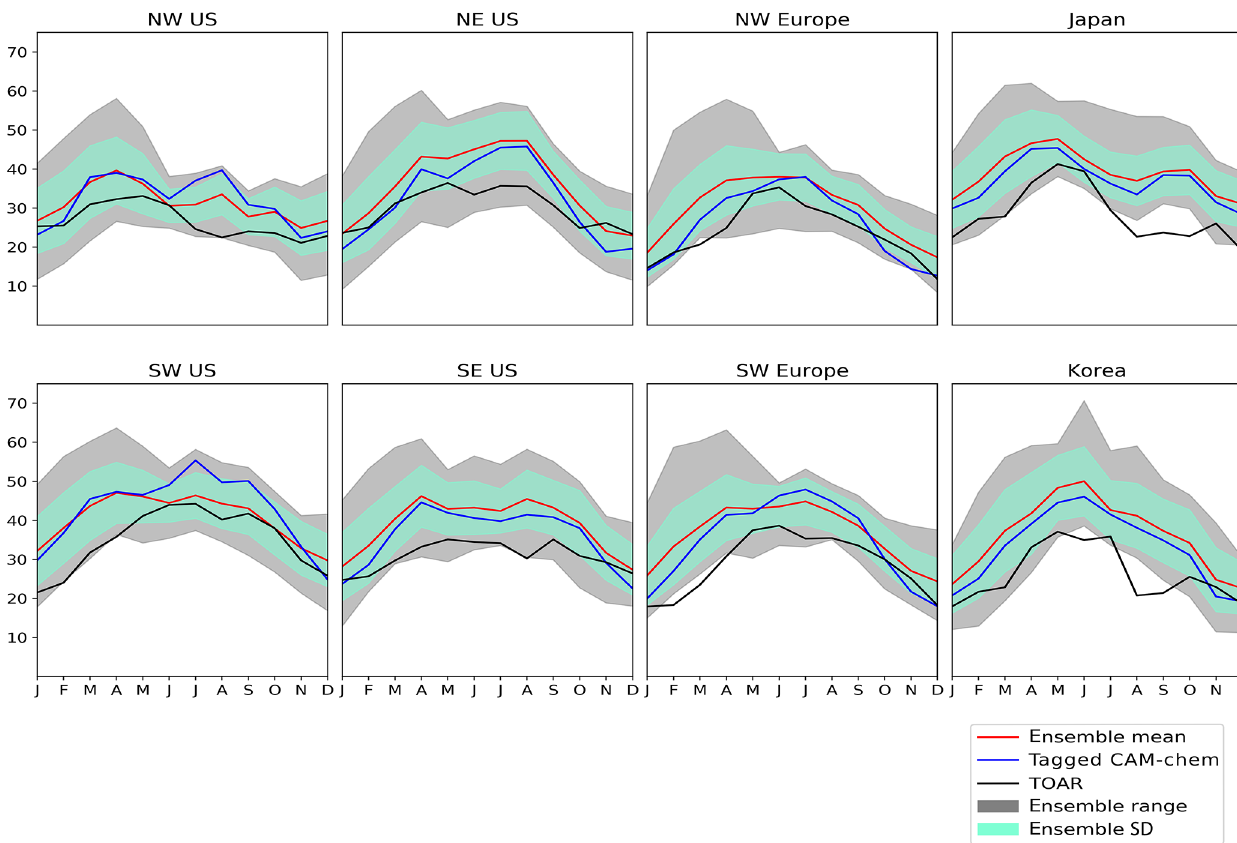
Figure 1. Seasonal cycle of monthly mean surface ozone (ppb) in Hemispheric Transport of Air Pollution (HTAP) Tier 2 regions from our base model run (blue line), compared with observations from the Tropospheric Ozone Assessment Report (TOAR; black line), and other models from the HTAP ensemble of global models: ensemble mean (red line), ensemble standard deviation (green shaded area), and ensemble range (grey shaded area). Only grid cells containing TOAR observations have been